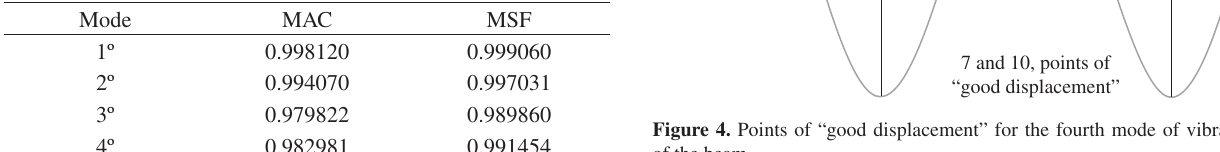
Table 5. MAC and MSF values between the numerical and experimental vectors for HLM graphite beam.